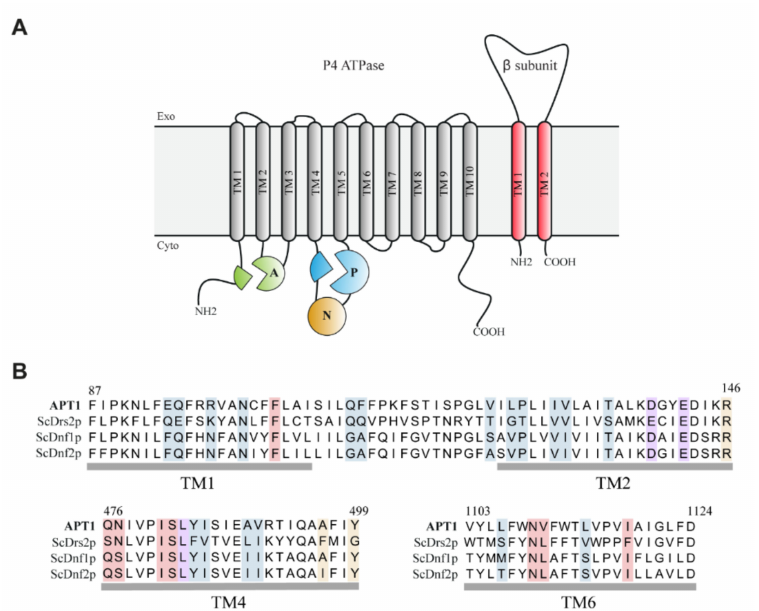
Figure 2. Apt1p belongs to the P4A-ATPase clade. Apt1p harbors functional motifs needed for lipid flipping. ( A ) Membrane topology of P4-ATPases and their β -subunit. P-type ATPases consist of an actuator (A), a phosphorylation domain (P), a nucleotide-binding domain (N), and 10 transmembrane (TM) spanning helices. The Cdc50 subunit consists of two membrane-spanning domains with a large extracellular loop containing four possible N-linked glycosylation sites and two disulfide bridges. ( B ) Alignment of TM1, 2, 4, and 6 of Apt1p and its nearest orthologs in S. cerevisiae . The sequences were aligned with Mega X using MUSCLE. Numbers above the alignment represent residues in Apt1p. Gray bars below it represent the transmembrane domains. Residues identified by structural information to be positioned along the lipid translocation pathway are highlighted in blue. Residues shown to be involved in a direct interaction with the lipid are shaded in red for lipid-binding site 1 (loading) and in gold for lipid-binding site 2 (unloading). Residues shaded in purple have been suggested to be required for membrane deformation facilitating lipid loading. For accession numbers, see Materials and Methods. For full sequence comparison, see Supplementary Figure